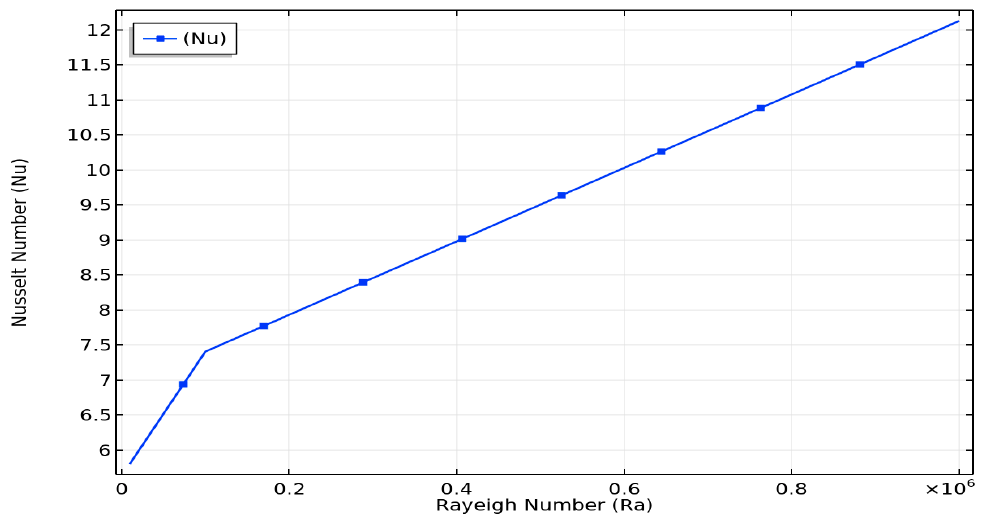
Figure 8. Graphical demonstration of variation in Nusselt number (𝑁𝑢) and w.r.t Rayleigh number (𝑅𝑎). Variation in the vertical constituent of the velocity by drawing a cutline at 𝑦 = 0.5 is analyzed in Figure 9a. From the overview of the sketch, it is seen that velocity along the cutline varies in the waveform. In addition, two wave structures are formed, one before the interaction of the fluid with a U-shaped fin, and the other after the passage of fluid to the obstruction. From the attained structures, it is seen that velocity behaves oppositely for the concerned cases. It is worthwhile to mention that absolute maxima of curves is attained at 𝑥 = 0.17 and 𝑥 = 0.63 , while absolute minima are attained at 𝑥 = 0.04 and 𝑥 = 0.71 .